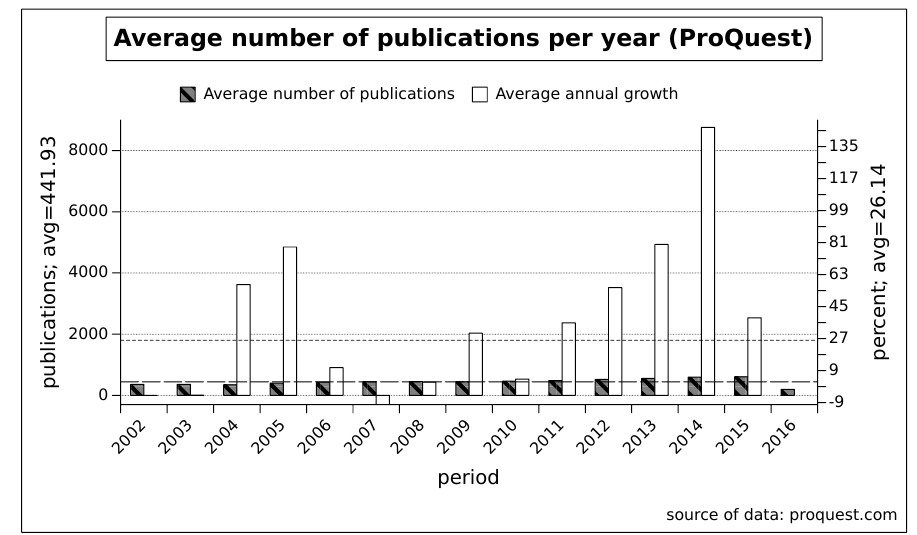
Figure 11. Average number of publications and annual average growth for the combined results from proquest.com for